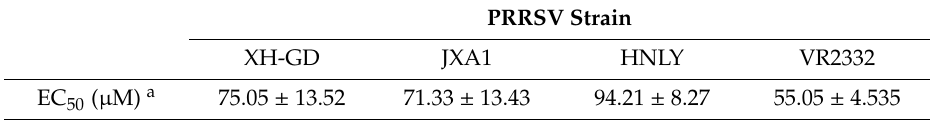
Table 2. Inhibitory activity of Ginsenoside Rg1 against PRRSV infection in MARC-145